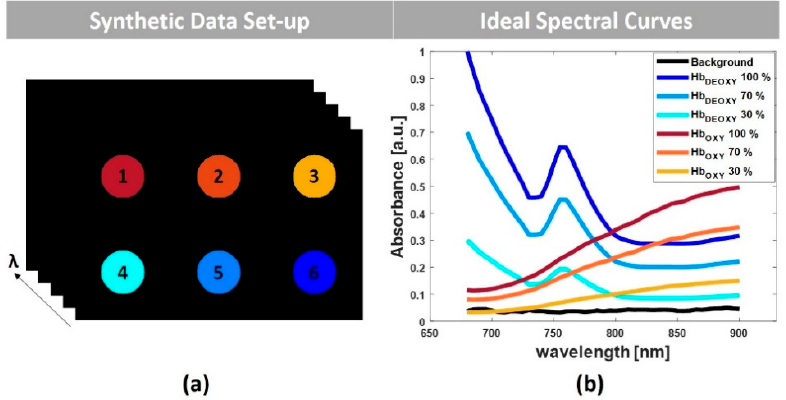
Figure 1. ( a ) Schematic representation of the simulated multispectral photoacoustic (PA) images with six inclusions, ( b ) ideal spectral curves of the inclusions.